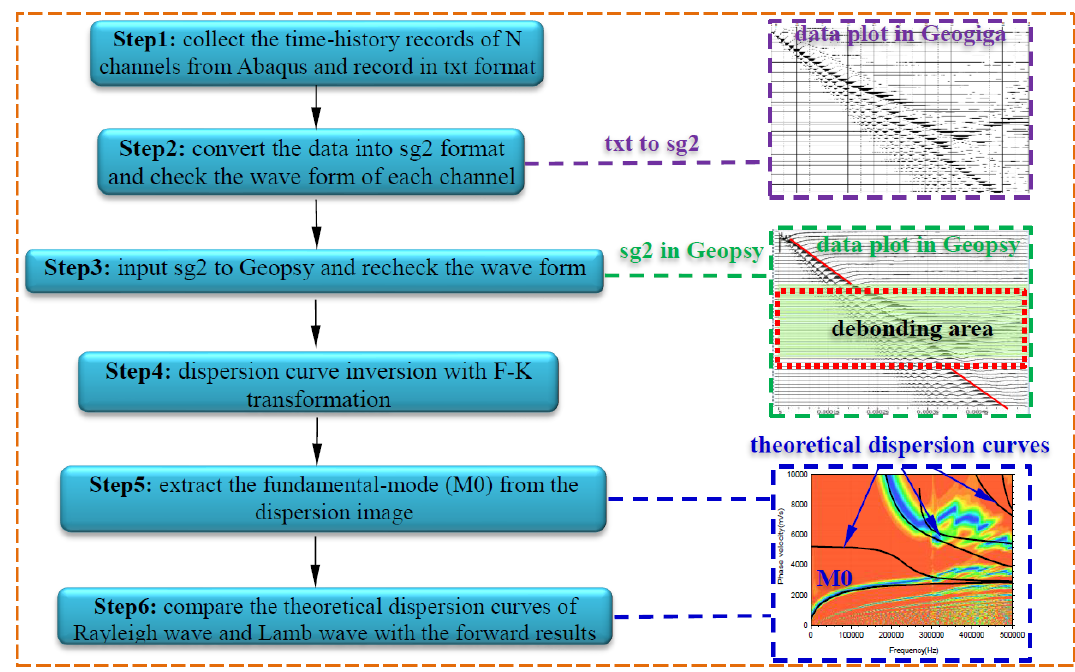
Figure 2. The half-period sine pulse signal.